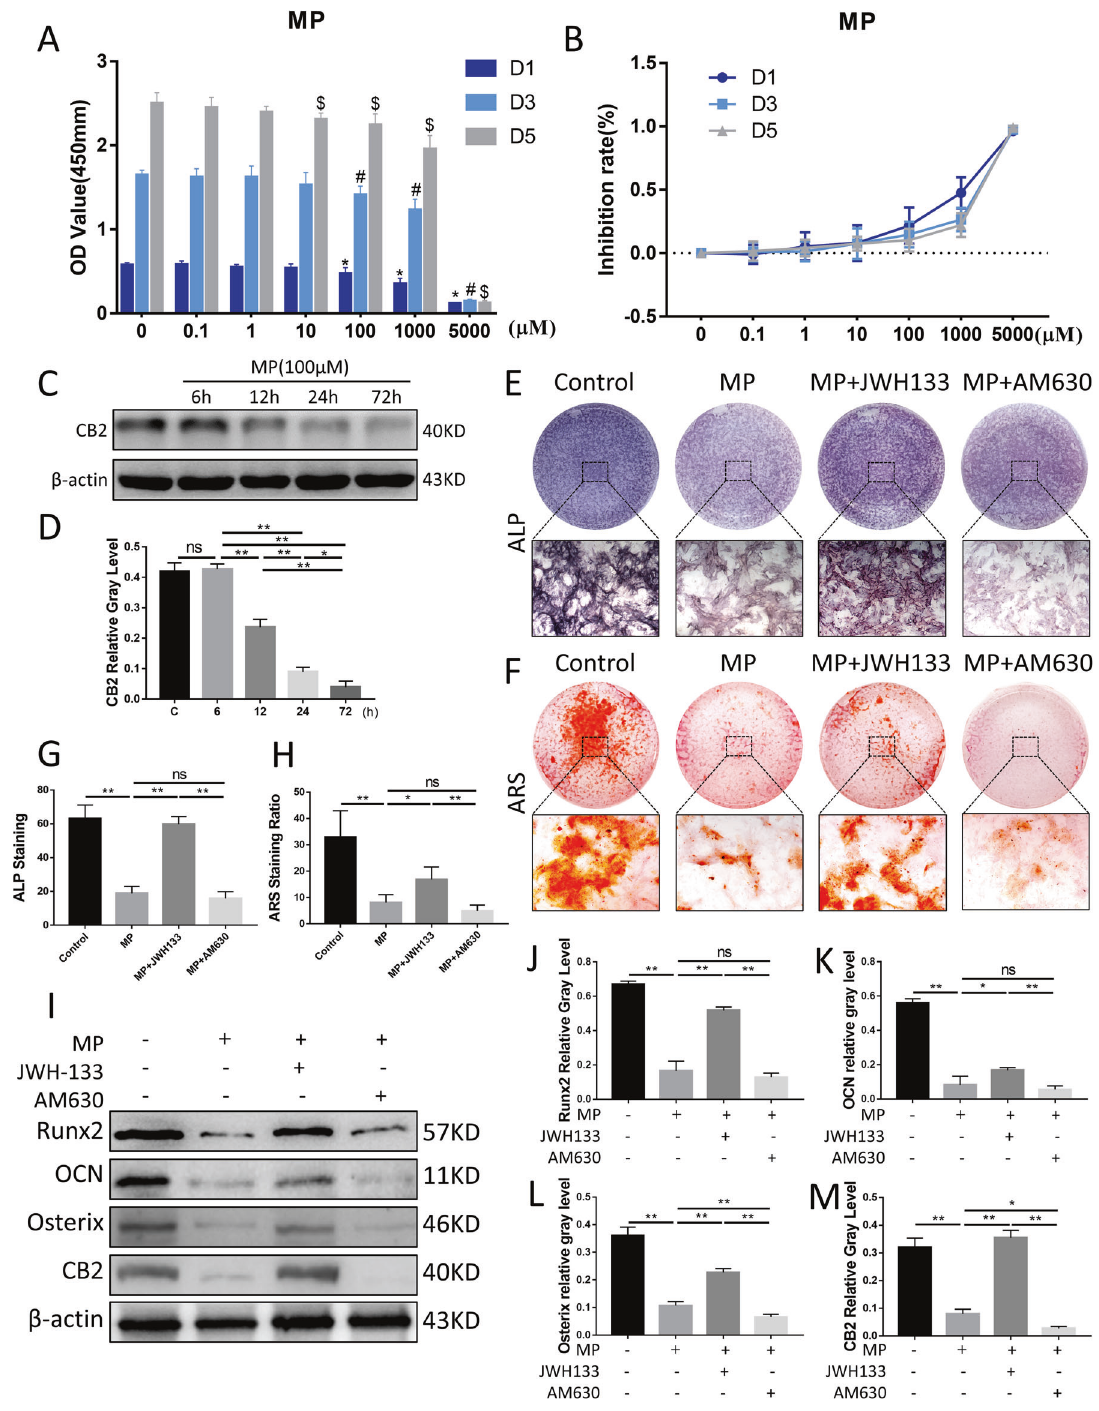
Fig. 4 Effects of MP and CB2 treatment on osteogenic differentiation and activity in BMSCs. A CCK-8 assay of MP in BMSCs. * p < 0.05, compared with control group (day 1), # p < 0.05, compared with control group (day 3), and $ p < 0.05, compared with control group (day 5). B Inhibition rate of BMSCs. C , D CB2 expression under different duration of MP 100 μ M intervention. E , G ALP staining and analysis. F , H ARS staining and analysis. I – M Protein expression levels of Runx2, OCN, Osterix, and CB2 ( n = 3 per group, data are shown as mean ± SD, * p < 0.05; ** p < 0.01; ns, not signi fi